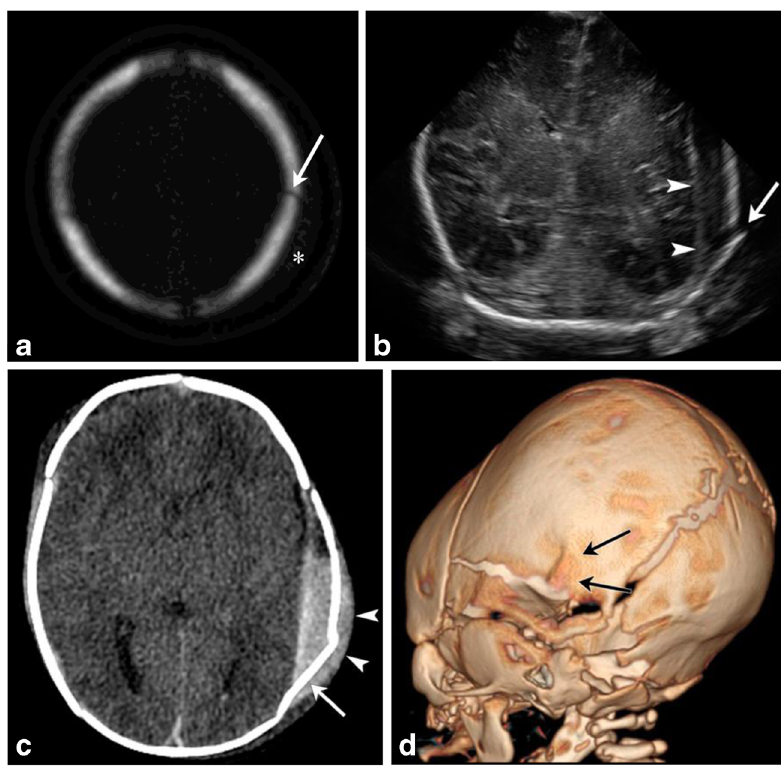
non-contrast head CT image (c) shows a complex left parietal bone fracture with an angulated anterior component and an adjacent depressed B ping-pong ^ fracture component posteriorly (arrow). There is an associated overlying hyperdense fluid collection consistent with cephalhematoma (arrowhead). There is also an underlying large epidural hemorrhage with fluid/fluid levels. 3-D volume rendered image (d) re-demonstrates the complex left parietal bone fracture (black arrows)